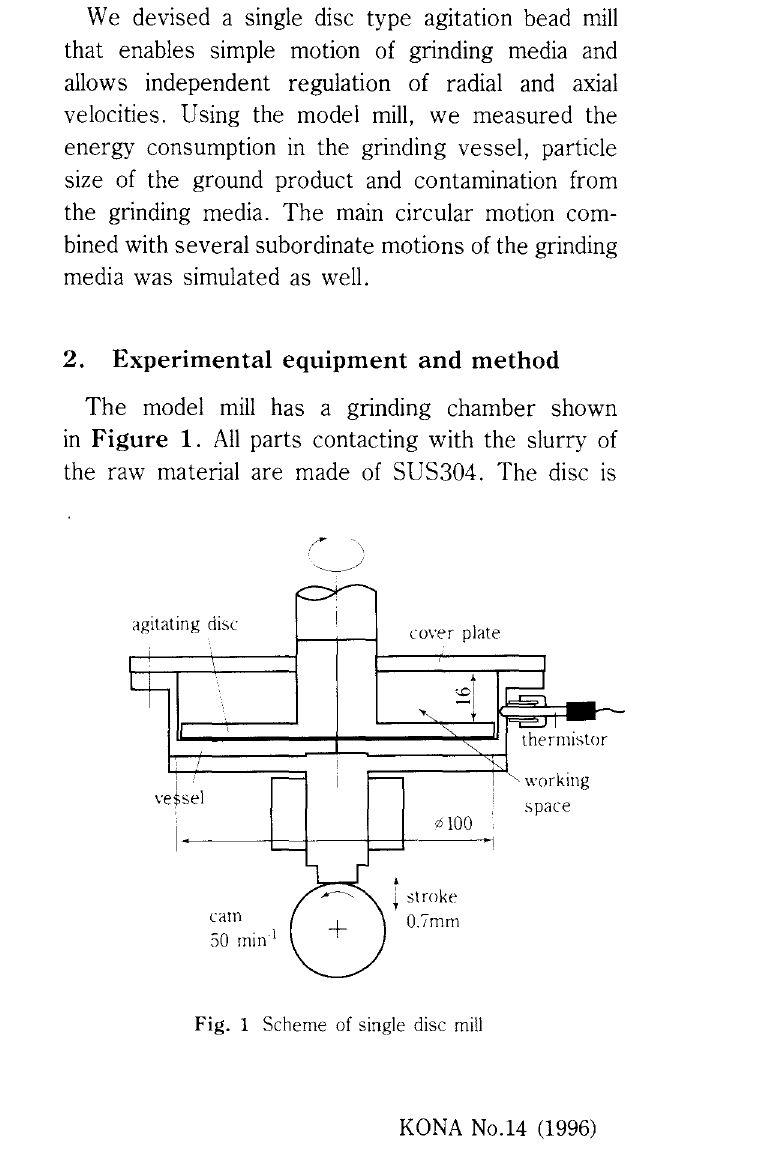
Fig. 1 Scheme of single disc